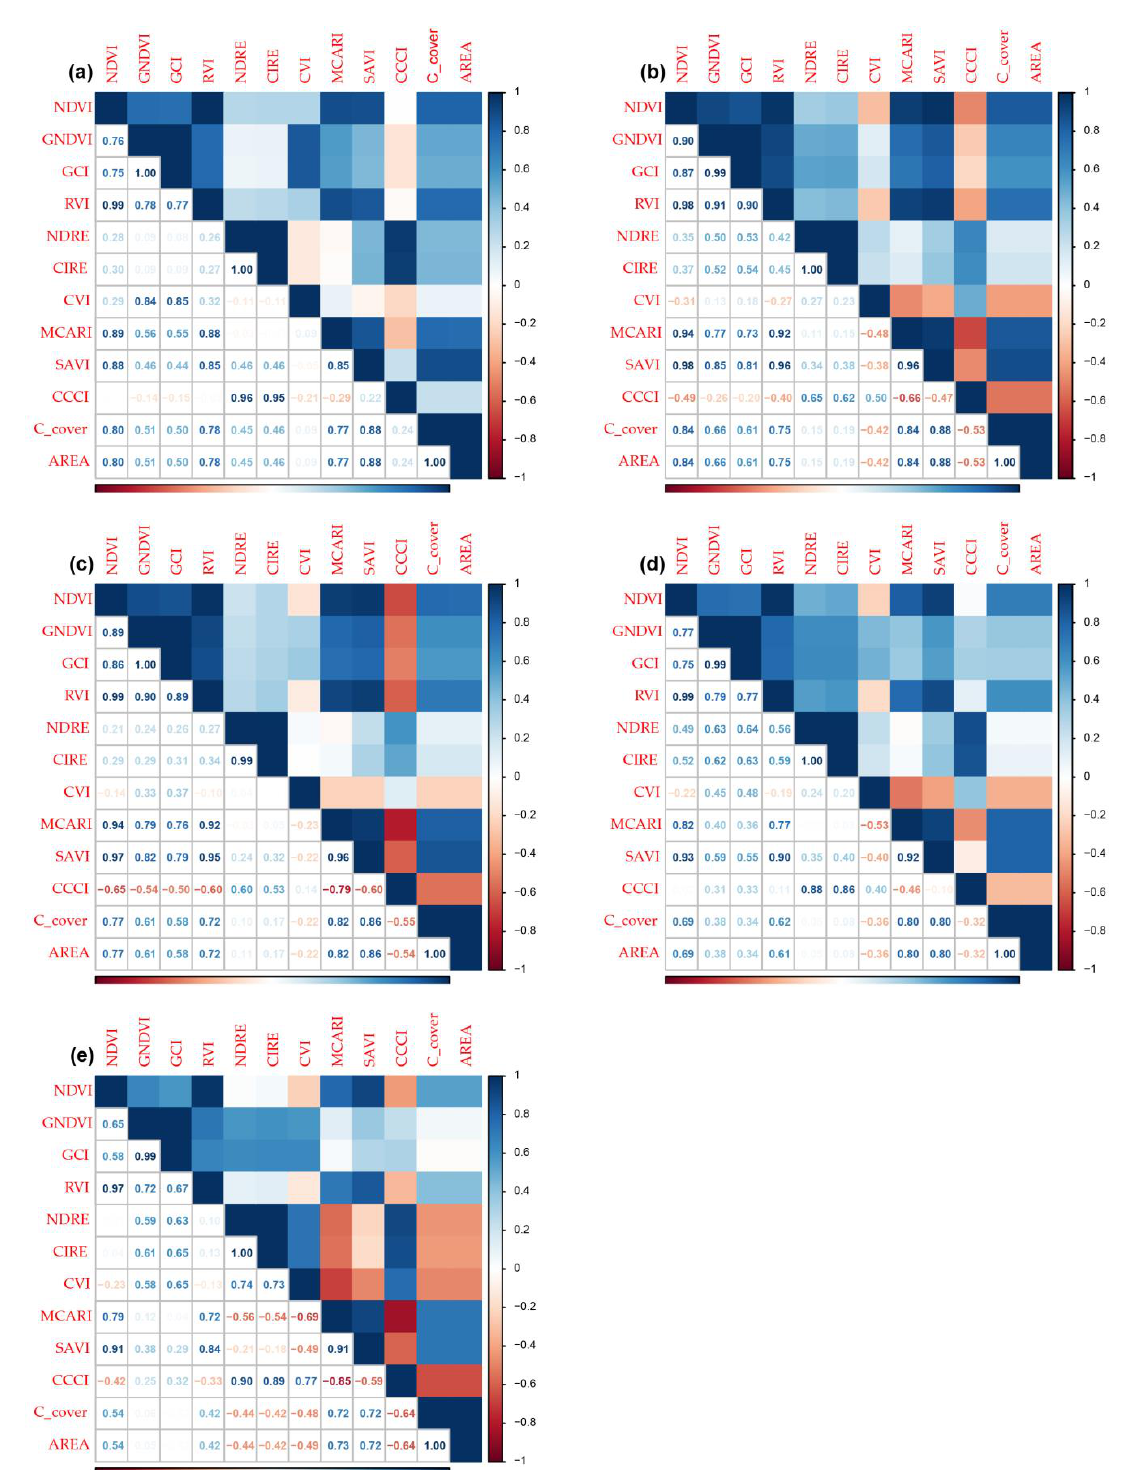
Figure 4. r-Pearson correlation between maize yield with canopy cover and vegetation indices: ( a ) 31 DAS; ( b ) 39 DAS; ( c ) 42 DAS, ( d ) 46 DAS; ( e ) 51 DAS. The relationship between canopy cover and VIs is shown. The NDVI, MCARI and SAVI indices reported highly significant correlations for all evaluation days,